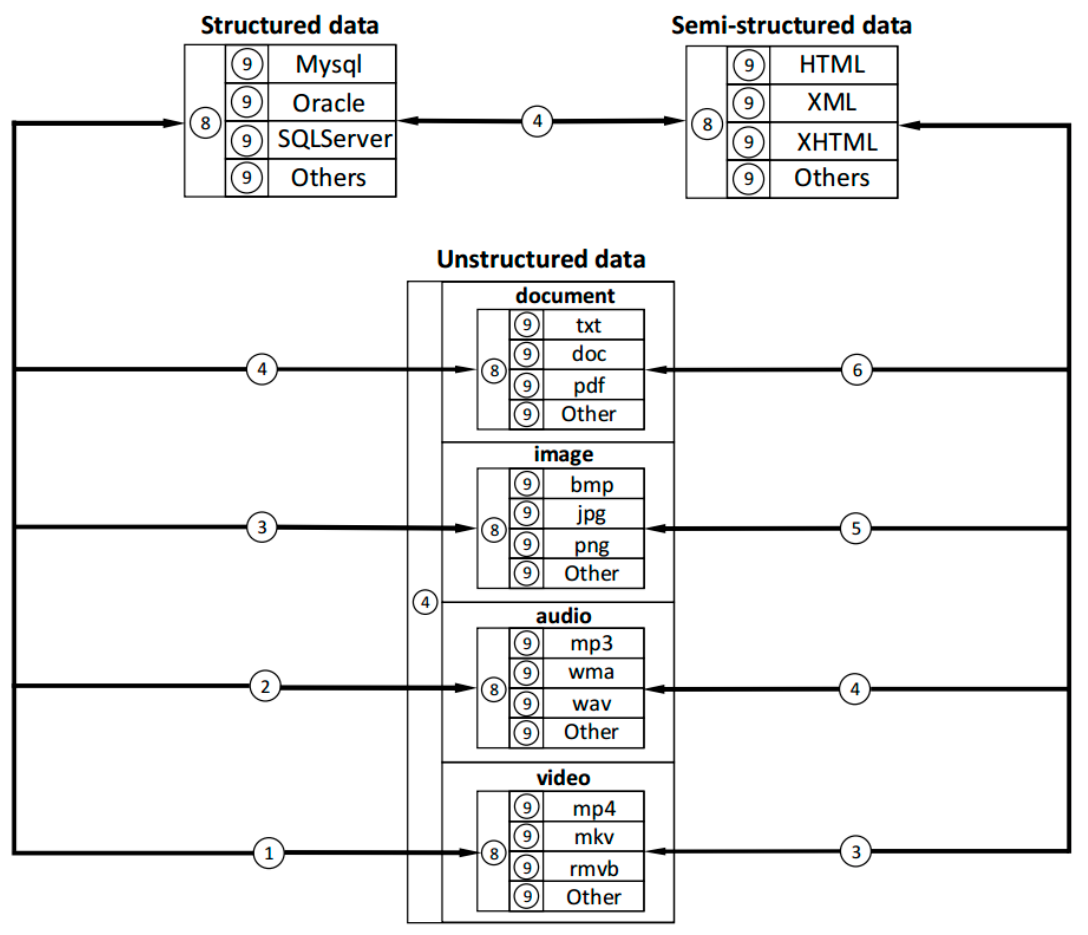
Figure 1. The calculation rule of C f value.